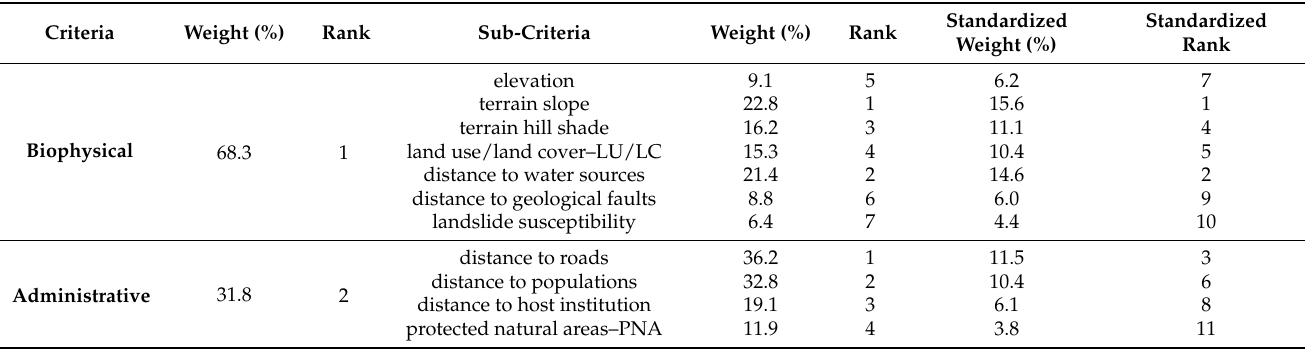
Table 4. Importance weights (%) for the second and third hierarchies of criteria for selecting sites for weather stations in Amazonas, NE Peru.